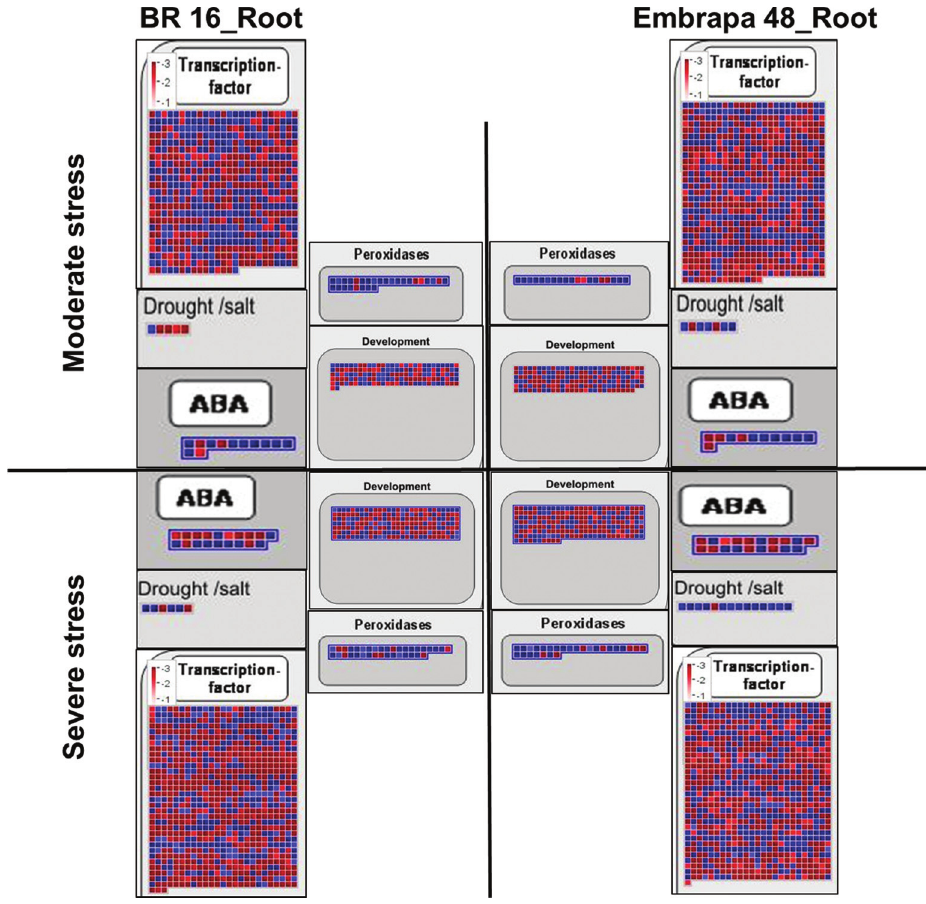
Figure 10 - Modified maps of MapMan 3.6 ORC. Genes that were differentially expressed in response to water deficit were mapped to specific stress-related pathways for root from BR 16 and Embrapa 48 under moderate and severe stress. The color scale shows the log2 fold-change: red = down-regulated and blue =